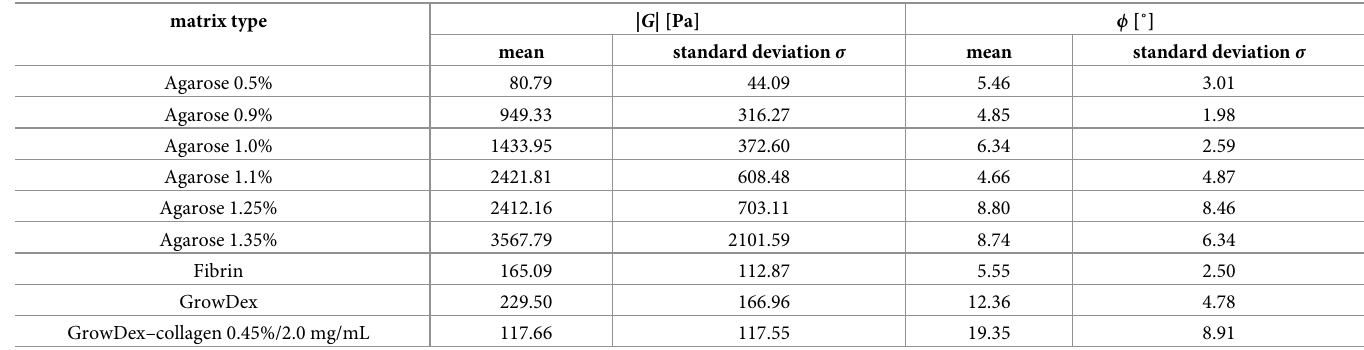
Table 2. Microrheometry for the viscoelasticity of the matrix types. matrix